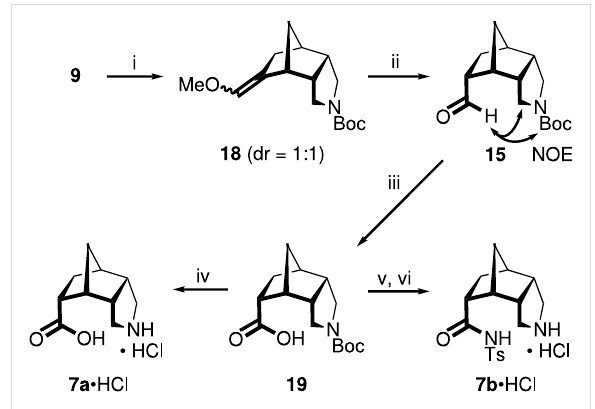
N , O -acetal rac - 17 in 35% yield. The latter compound is presumably formed from rac - 15 by a Lewis acid-catalyzed, intramolecular, and thus proximity-facilitated tandem hydride transfer/cyclization sequence